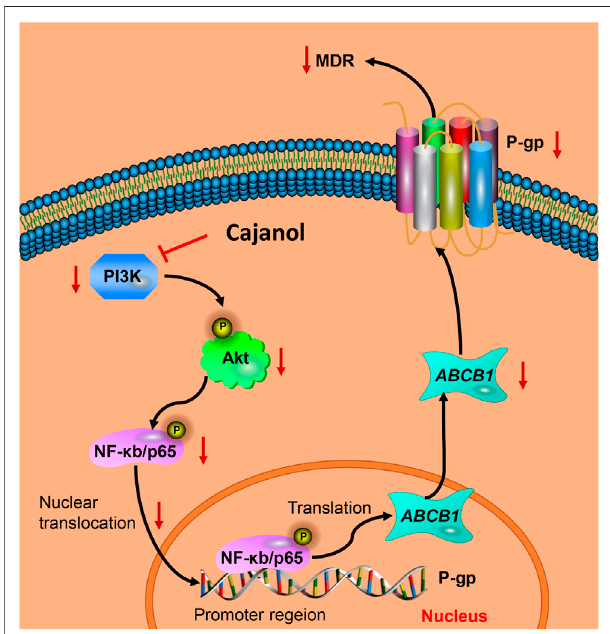
FIGURE 6 | Cajanol treatment down-regulates P-gp expression via inhibition of the PI3K/Akt/NF- κ B signaling pathway. Cajanol inhibits the phosphorylation of I κ B and the translocation of NF- κ B from the cytoplasm to the nucleus by inhibiting the expression ofPI3K and the phosphorylation of Akt, and ultimately inhibits the transcription and translation of the P-gp